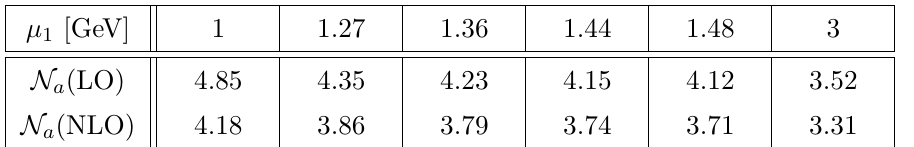
+ 3 C 2 + 2 C . 1 C 2 1 2